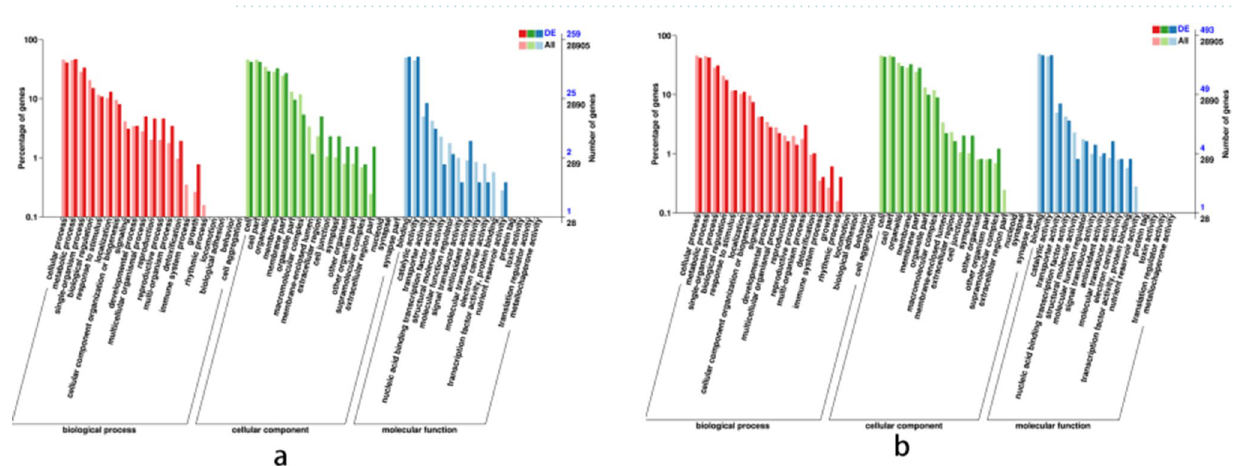
Figure 6. GO annotation classification statistical map of different expression genes. ( a ) Description of what is WT vs AS GO classification; ( b ) description of what is WT vs OE GO